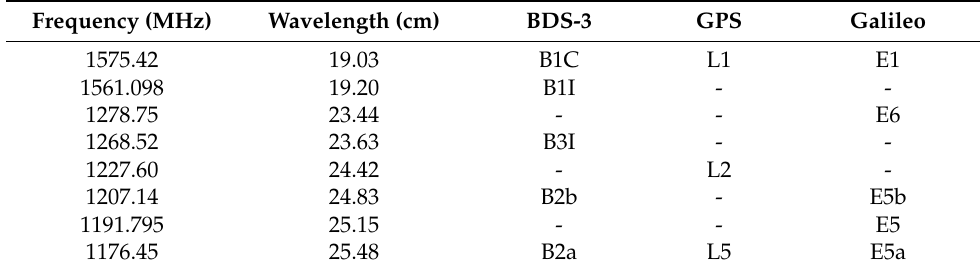
Table 1. Frequency and wavelength of BDS-3/GPS/Galileo.